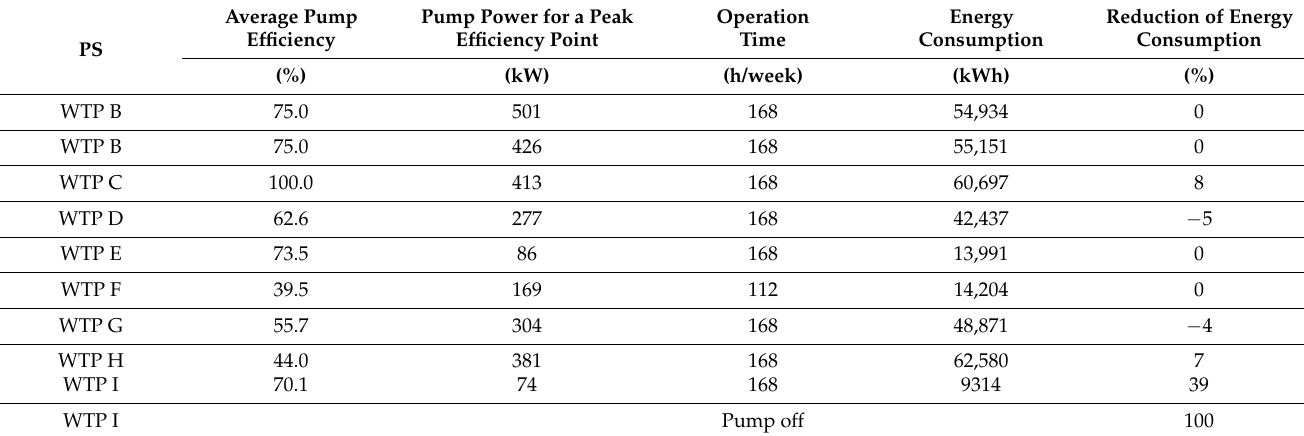
Table 5. The results obtained in Scenario no.